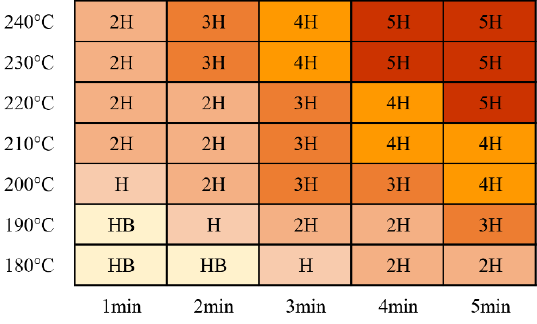
Figure 12. Coated pencil hardness test results for the coatings.